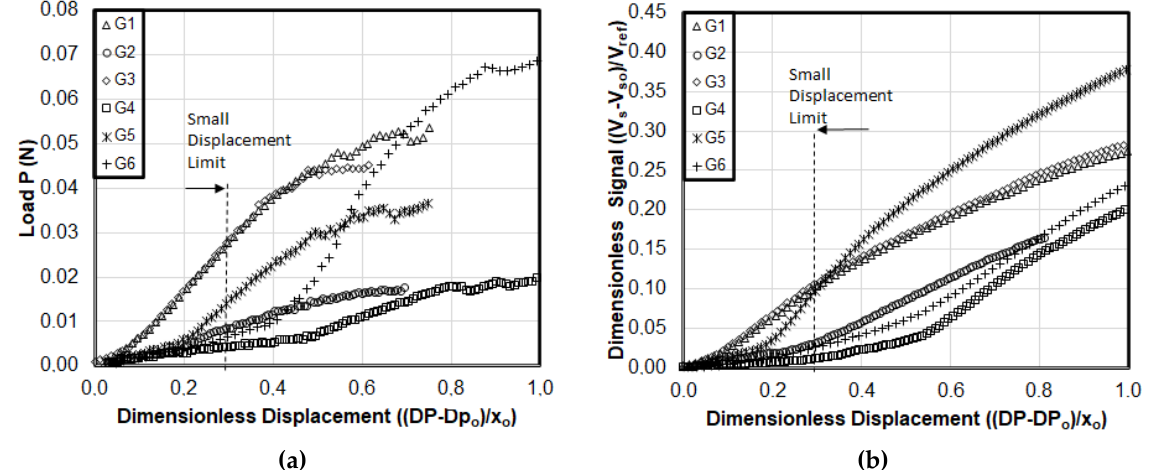
Figure 5. Average load and instrumental signal curves obtained from the two-point bending tests: ( a ) dimensionless load – displacement curve, ( b ) dimensionless instrumental signal – displacement ( a ) dimensionless load–displacement curve, ( b ) dimensionless instrumental signal–displacement curve.